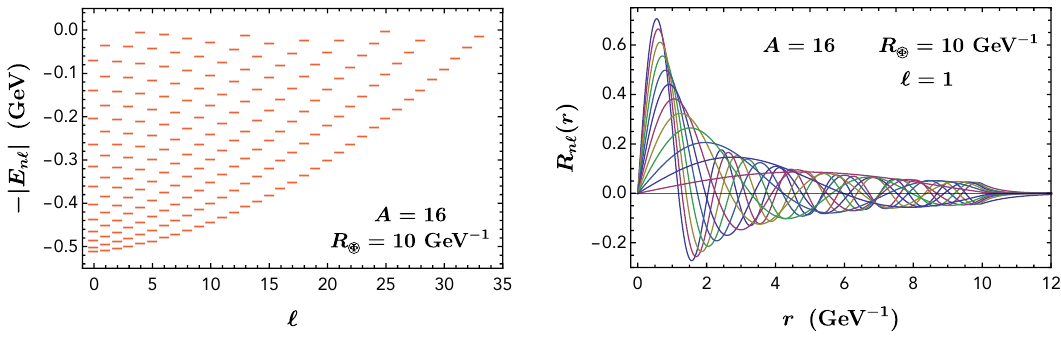
Figure 1 . Left panel: the energy levels for nucleus-DMB bound states for di(cid:11)erent partial wave numbers ‘ . Right panel: the 12 radial wave functions as a function for r for the p -wave bound states with ‘ =